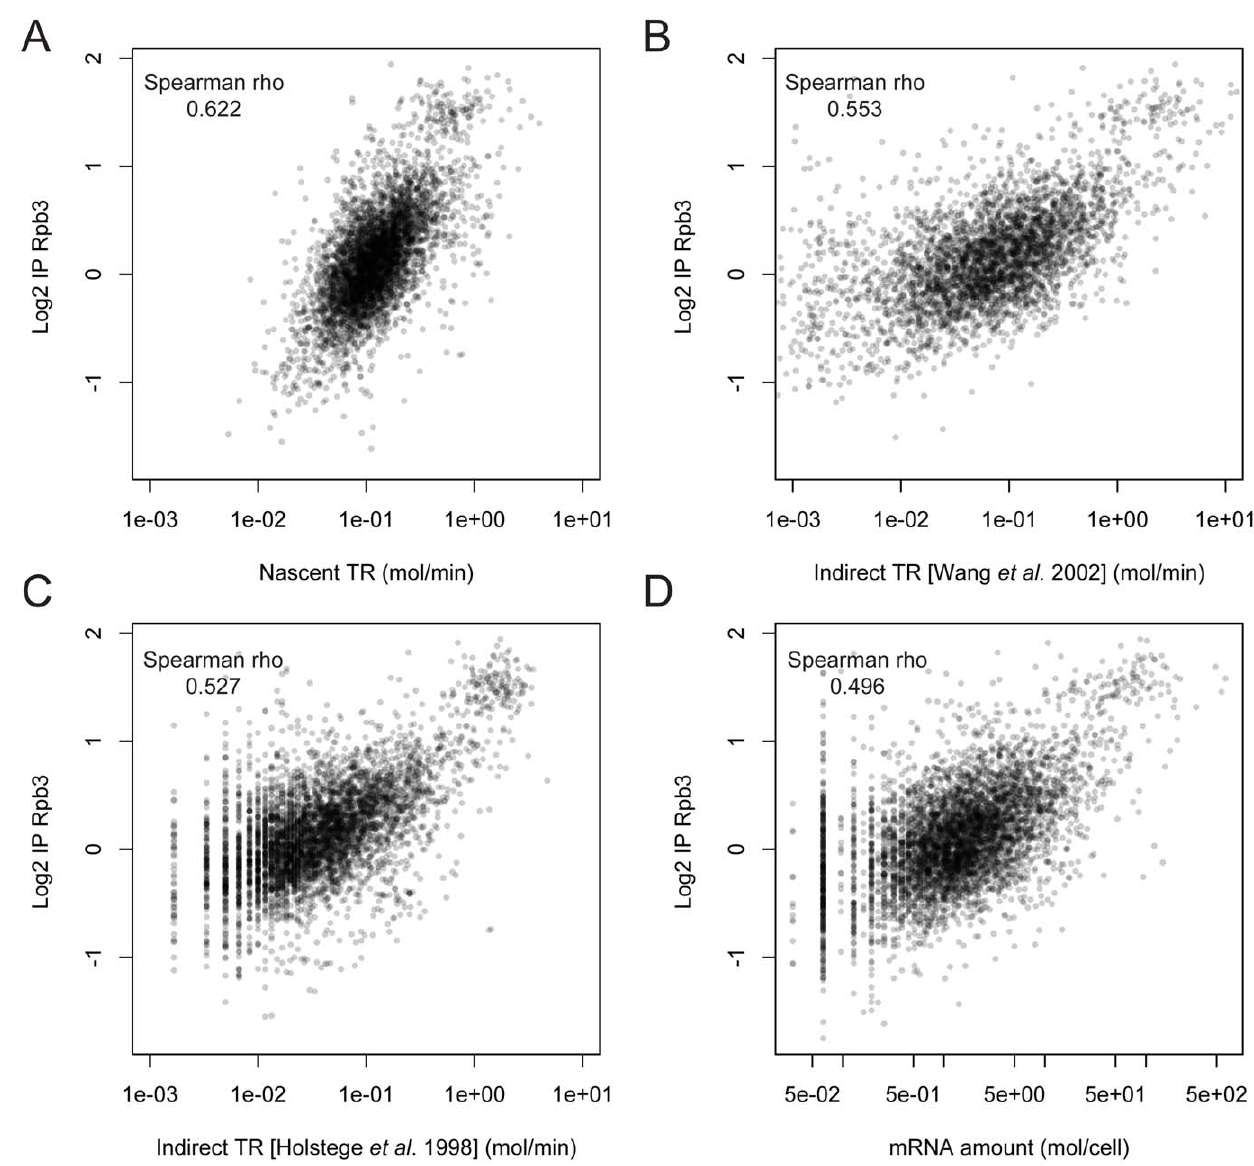
Figure 2. Comparison of the direct and indirect TR datasets with presence of RNA pol II. Comparison of the new direct TR dataset (this study) and indirect TR datasets computed using the mRNA amount and the mRNA stability [9,17] as in Fig. 1 with RNA pol II data (average IP along the coding region of Rpb3-TAP) [18]. To avoid any bias depending on the wideness of the datasets Spearman rank correlation is used. Note that the correlations are always higher for the nascent TR dataset (A) than for the indirect datasets (B, C), and that the indirect TR datasets show a better correlation than the mRNA amount data set (D).